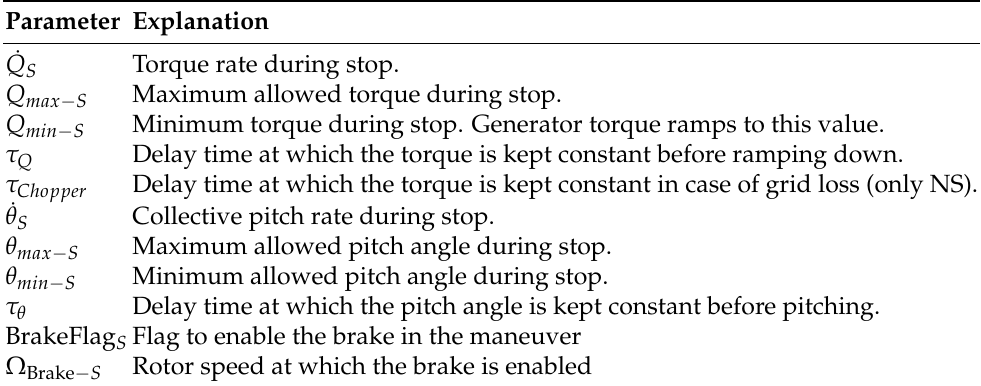
Table 2. Parameters for the normal and emergency stop maneuvers.